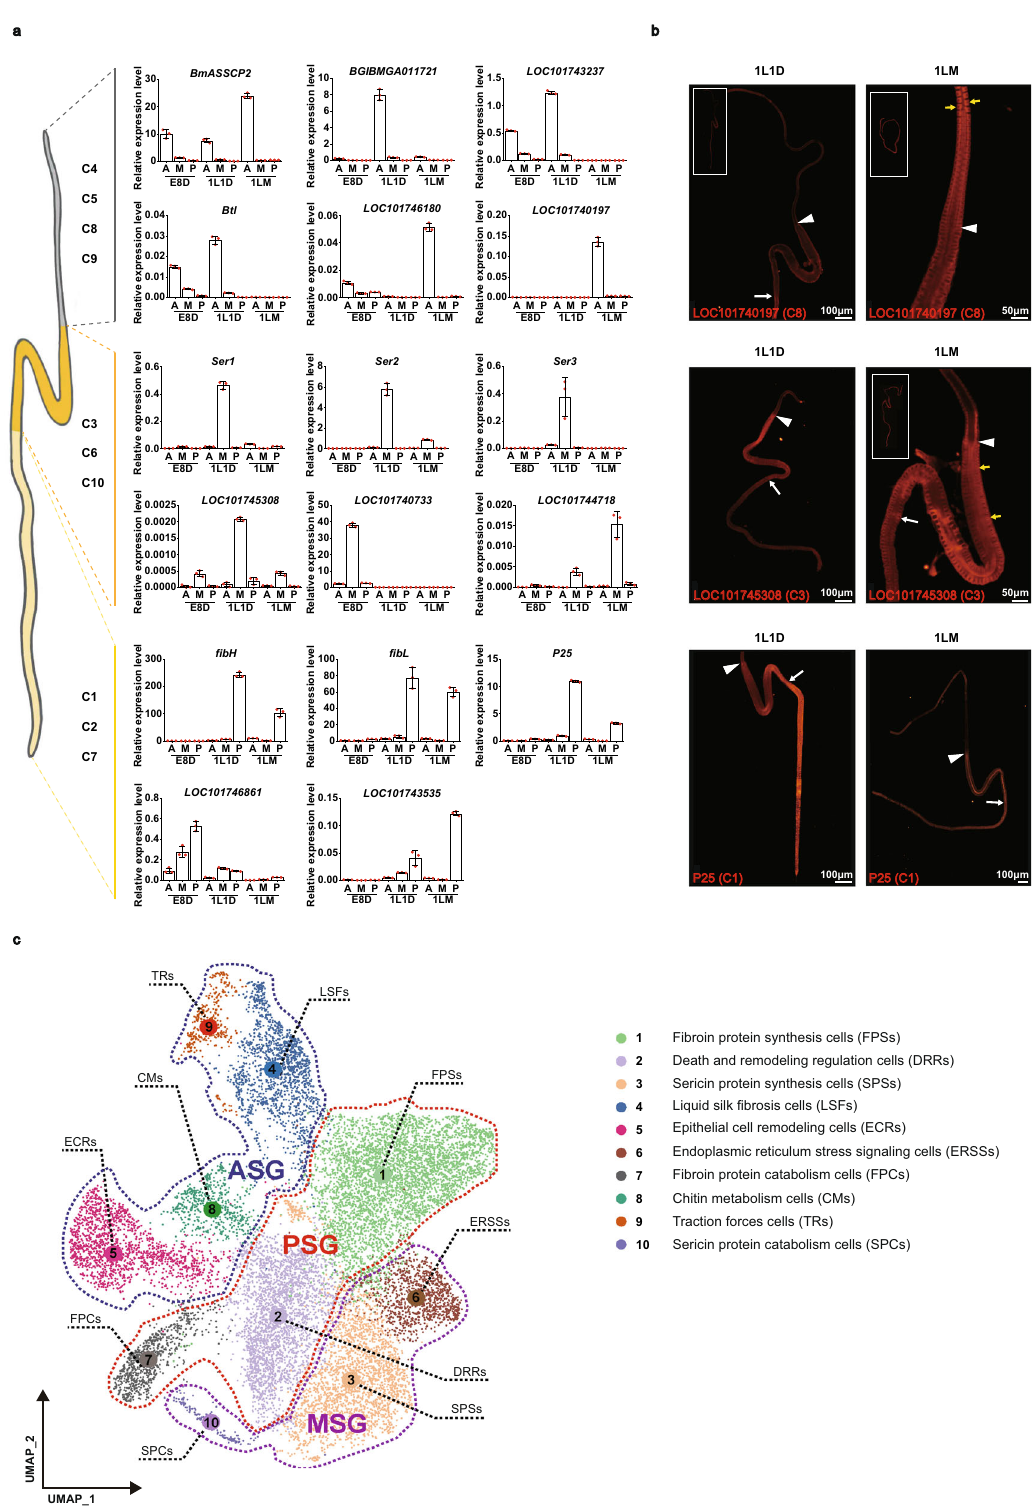
Fibroin protein synthesis cells (FPSs) Death and remodeling regulation cells (DRRs) Sericin protein synthesis cells (SPSs) Liquid silk fibrosis cells (LSFs) Epithelial cell remodeling cells (ECRs) Endoplasmic reticulum stress signaling cells (ERSSs) Fibroin protein catabolism cells (FPCs) Chitin metabolism cells (CMs) Traction forces cells (TRs) Sericin protein catabolism cells